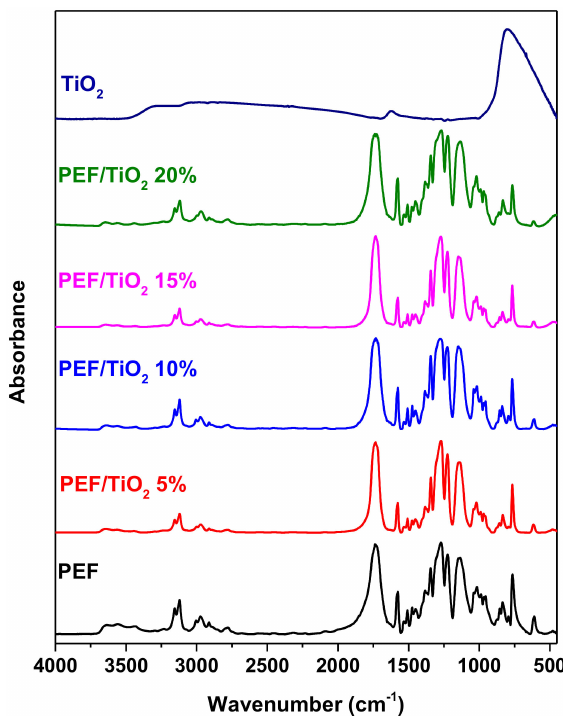
Figure 3. FTIR spectra of PEF and its nanocomposites with TiO 2 .